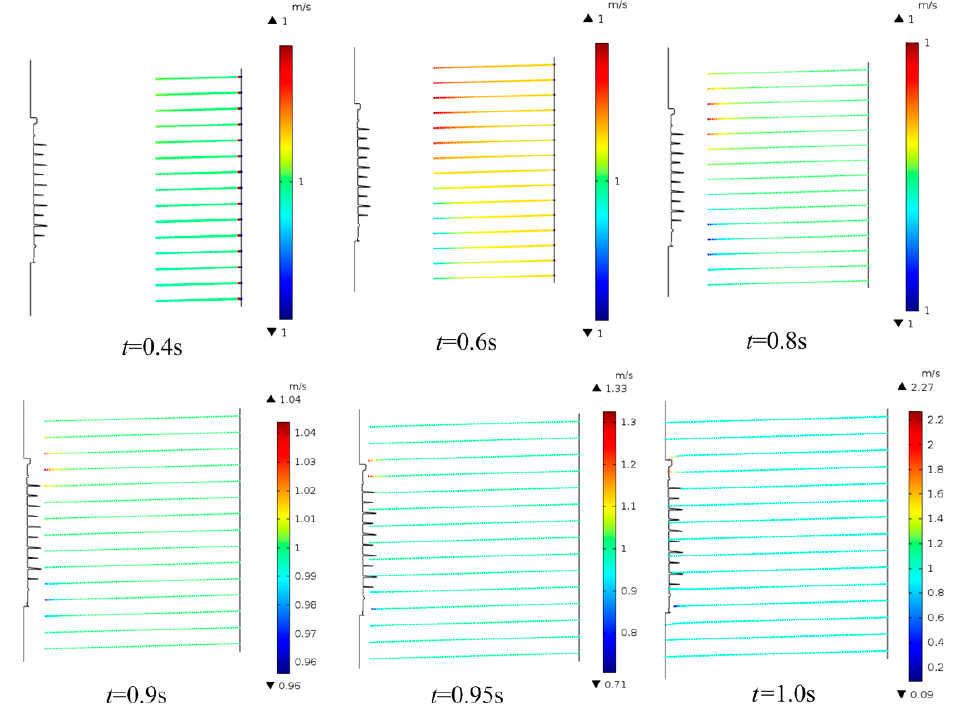
Figure 5. The particle movement process.